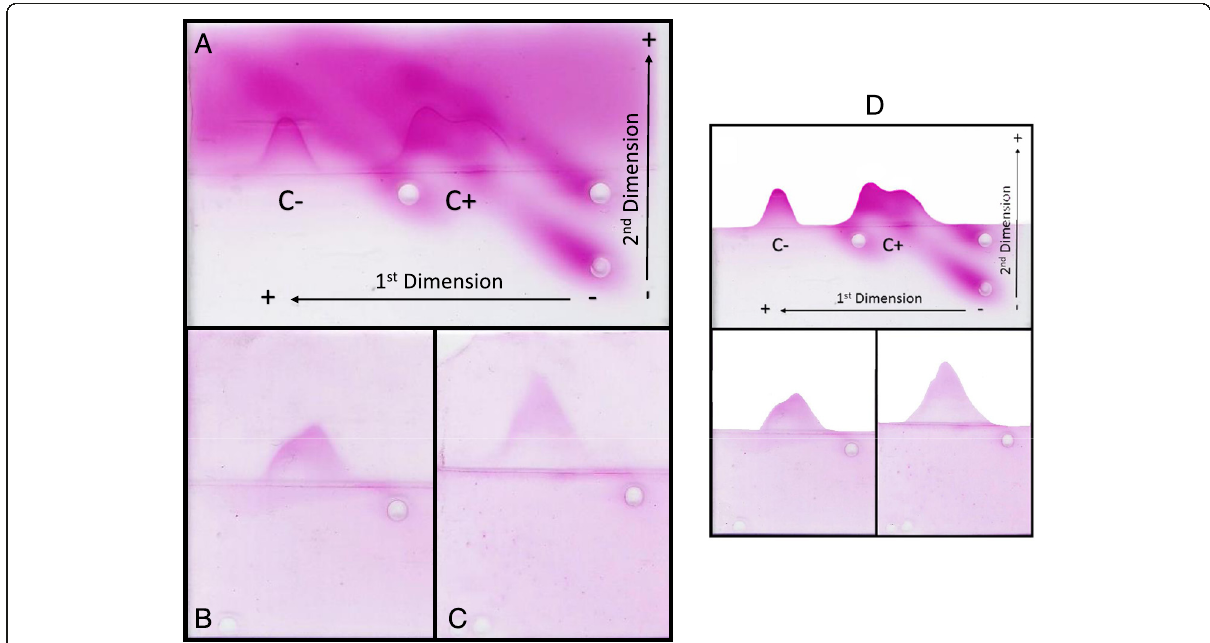
Fig. 4 Immunoelectrophoretic analysis of C3 in NHS incubated with fractions S2 and S5. a Positive control (C+) with zymosan (31.25 μ L, 1 mg/mL) and NHS (100 μ L, 1:2), and negative control (C-) with PBS (50 μ L) and NHS (100 μ L, 1:2). b Fraction S2 (50 μ L, A 280 ~ 0.2) with SHN (100 μ L, 1:2). c Fraction S5 (50 μ L, A 280 ~ 0.16) with NHS (100 μ L, 1:2). All mixtures were incubated for 60 min in a water bath at 37 °C. The plates were dried at room temperature, stained with 0.5 % Ponceau and bleached with 10 % acetic acid. Electrophoretic conditions: first dimension – four hours, 140 V at 15 mA and 10 W; second dimension – 14 h at 15 mA and 10 W. d Figures were manipulated to remove the background highlighting the presence of one peak for C- and two peaks for C+, S2 and S5